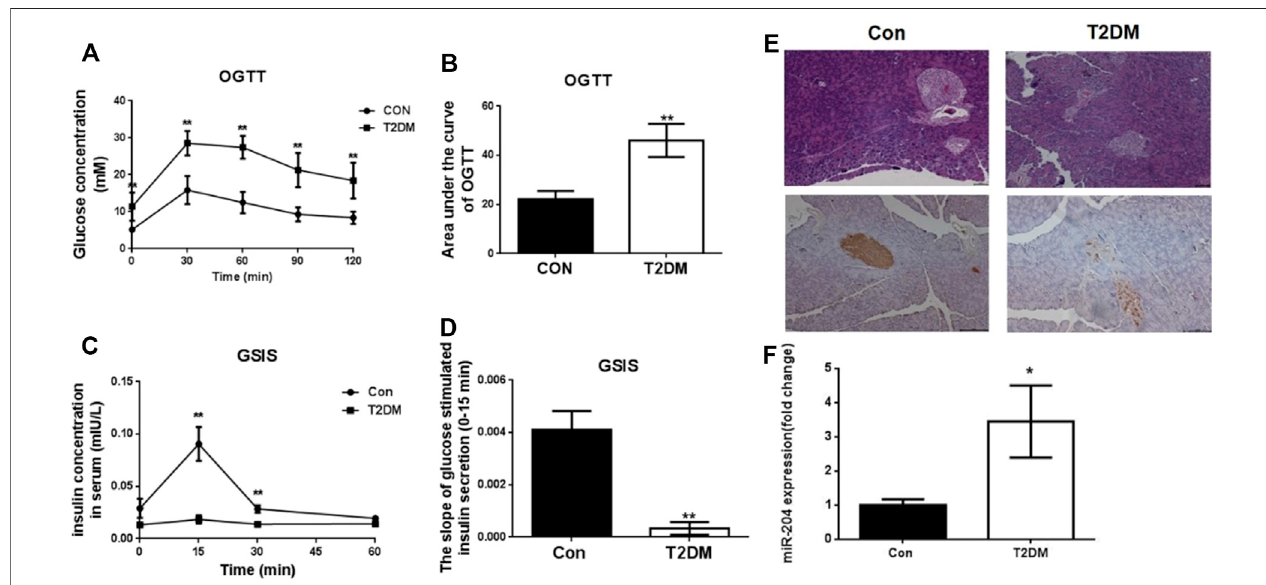
FIGURE 1 | Changes of OGTT, GSIS, morphological of islets and miR-204 levels in type 2 diabetic mice at the end of 16 week. (A, B) After orally gavage with glucose, the curve of OGTT and the area under the curve were measured in the CON and T2DM groups. CON: control group; T2DM: type 2 diabetes mellitus group.